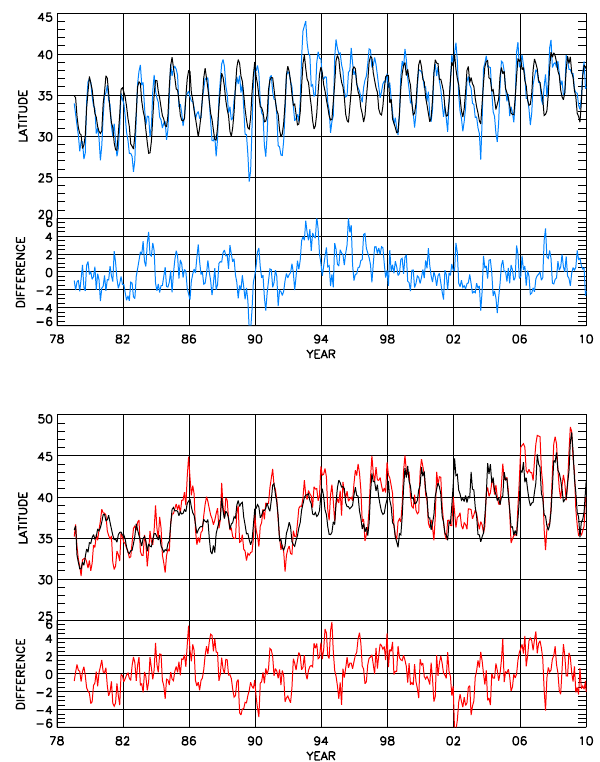
Fig. 5. Comparison of the measured monthly mean equivalent lat- itude of the subtropical front (red line) and the best fir from the re- gression analysis (black line) for the Northern and Southern Hemi- spheres. The blue line is a plot of the difference (measuredminus the best